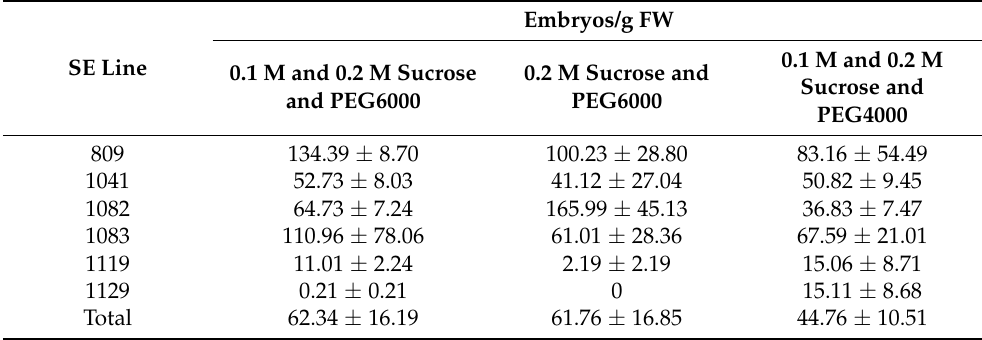
Table 5. Embryo production capacity per one gram of fresh weight of embryogenic tissue. Three cryovials containing embryogenic tissue from the same genotype from every experimental media were stored in liquid nitrogen and three maturations were made from regrowth from every treatment. Embryos/g SE Line